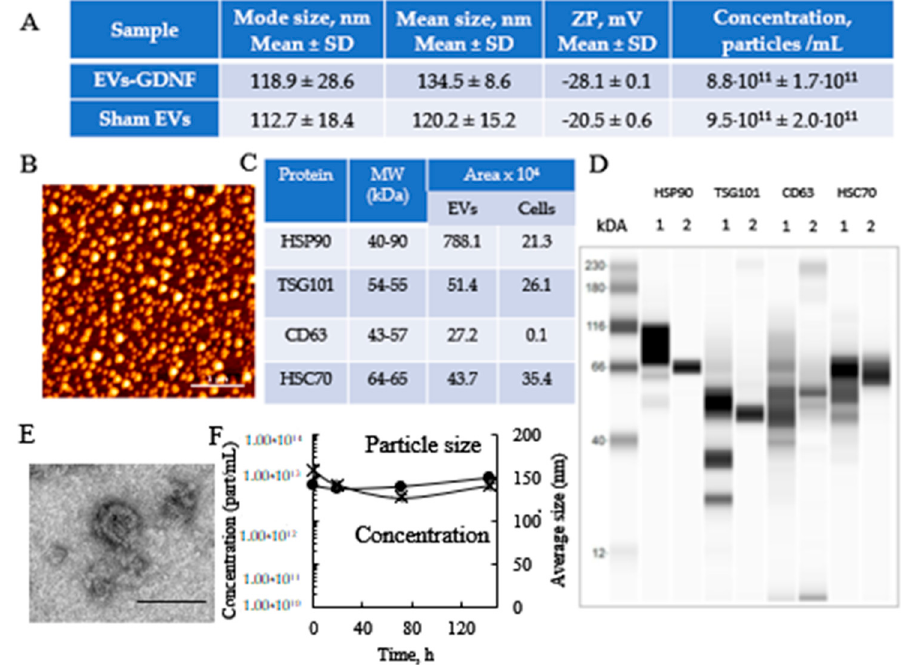
Figure 1. Characterization of EV-GDNF by ZetaView QUATT Nanoparticle Tracking Microscope PMX-420, AFM, TEM, and Western blot. Primary macrophages were transfected with GDNF-encoding pDNA by electroporation (condition #4), and EV-GDNF were collected from conditioned media on day 6. EV-GDNF were characterized for size, zeta potential, morphology, and stability by ZetaView QUATT Nanoparticle Tracking Microscope PMX-420 ( A ), AFM ( B ), and TEM ( E ). The abundance of EV-specific membrane proteins in GDNF-EVs ( 1 ) and much less—in parent macrophages ( 2 ) was confirmed by Wes TM ( D ) and quantified using Compass SW software ( C ). High stability of EV-GDNF nanoparticles was demonstrated over a week by NTA ( F ). The bar: 1 µm for AFM ( B ) and 100 nm for TEM ( E ).